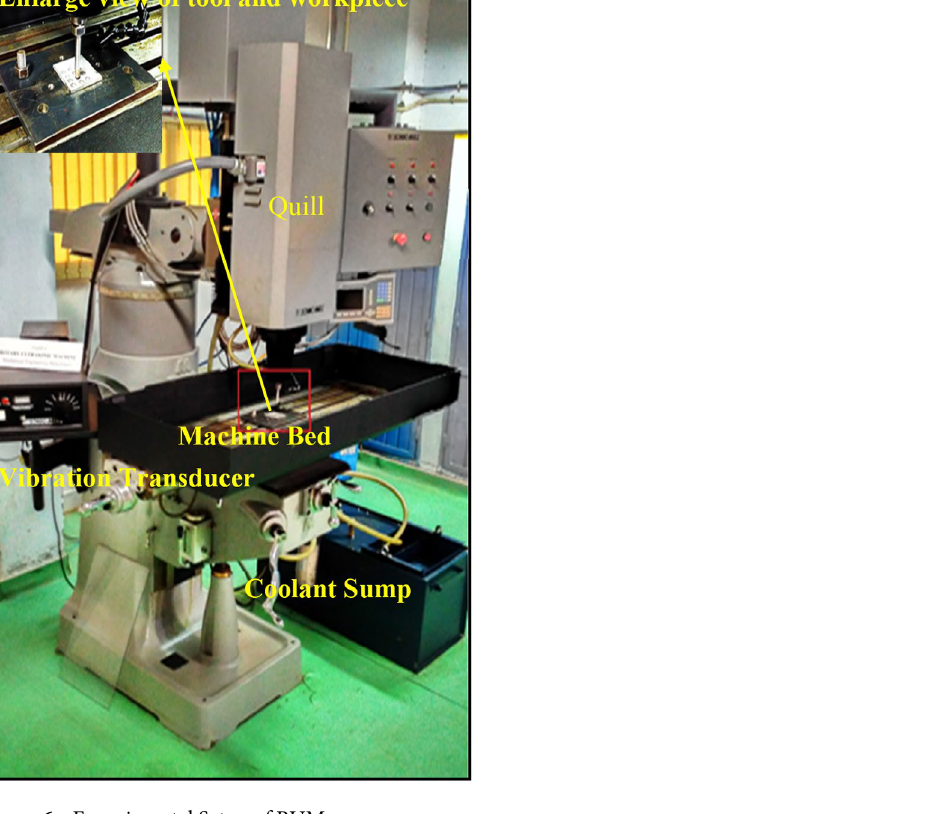
Figure 6. Experimental Setup of